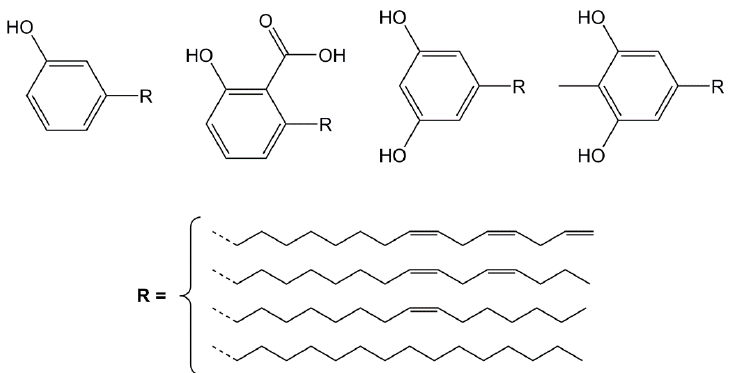
Figure 9. Main phenolic constituents of cashew nut shell liquid (from left to right): cardanol, anacardic acid, cardol and 2-methyl cardol [104].